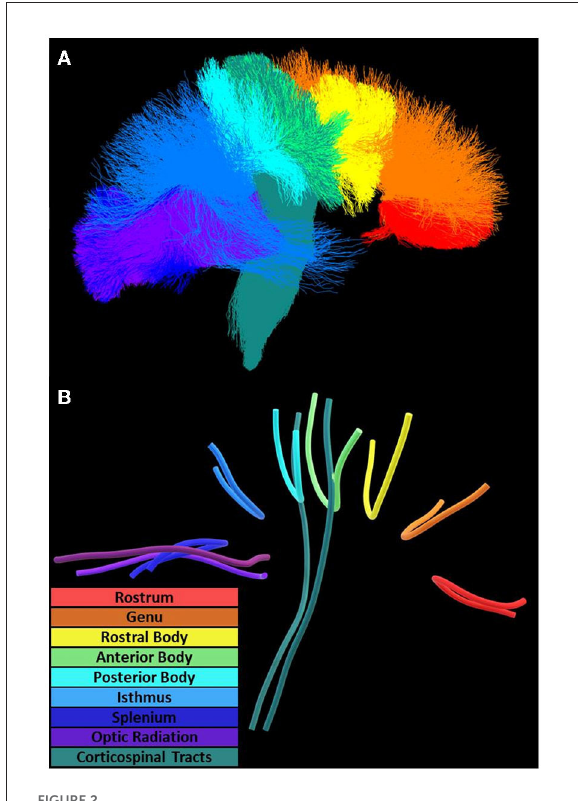
FIGURE2 Diffusion tractography and tract geometries. Along-tract analysis of the corpus callosum, optic radiation, and corticospinal tracts utilized (A) tractography oriented posterior (left) to anterior (right) and (B) mean tract geometries for within-tract